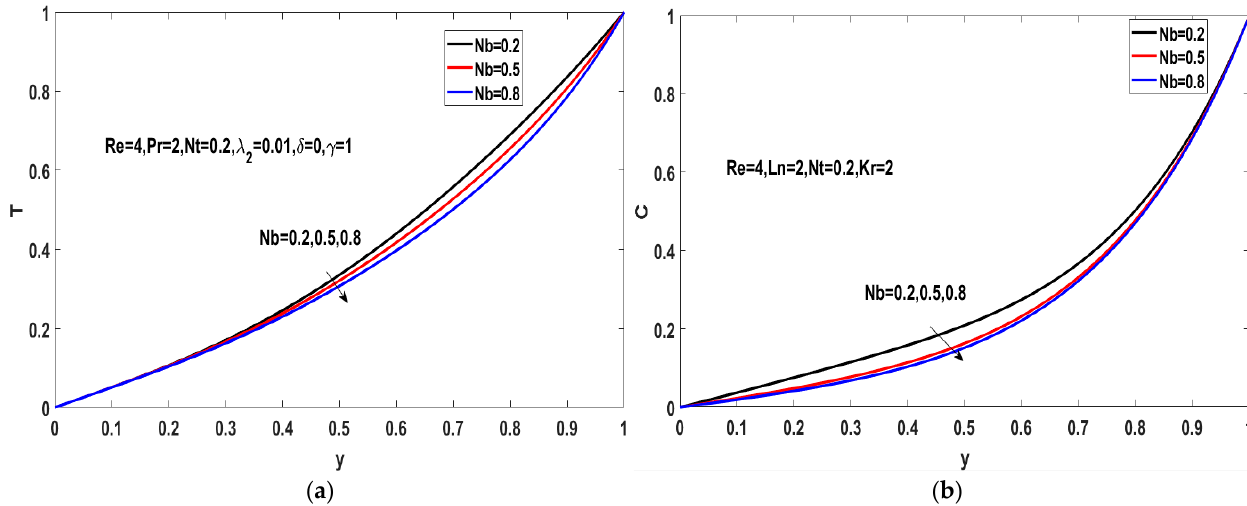
Figure 7. Effects of Nb : ( a ) on temperature distributions; ( b ) on concentration distributions.